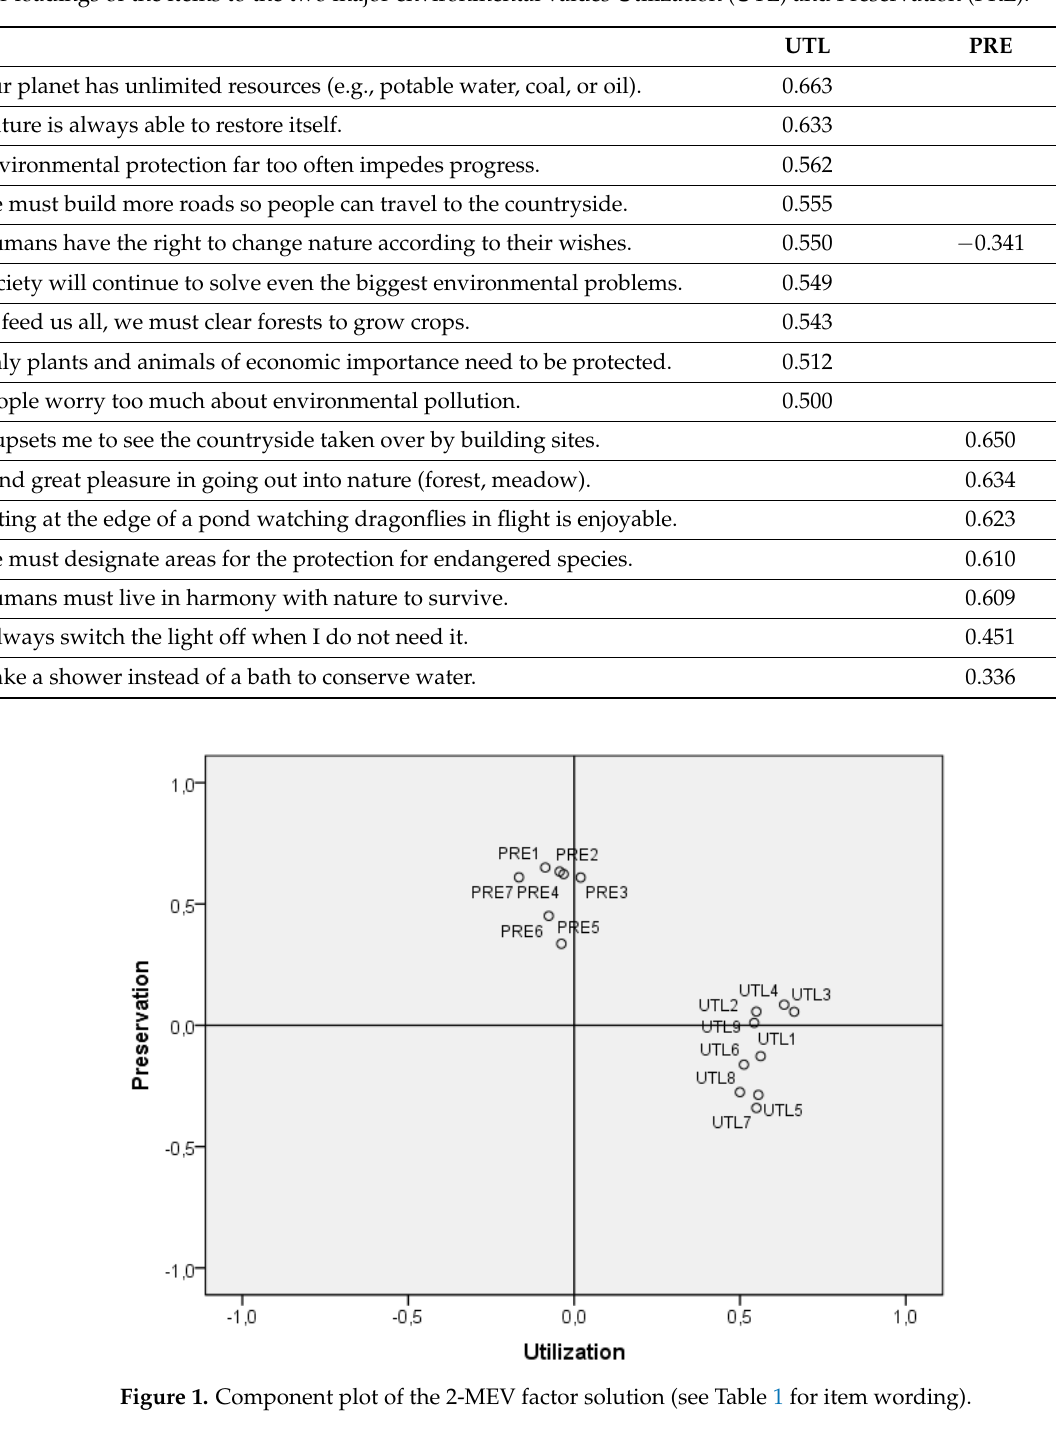
Table 2. Factor loadings of the items to the two major environmental values Utilization (UTL) and Preservation (PRE).